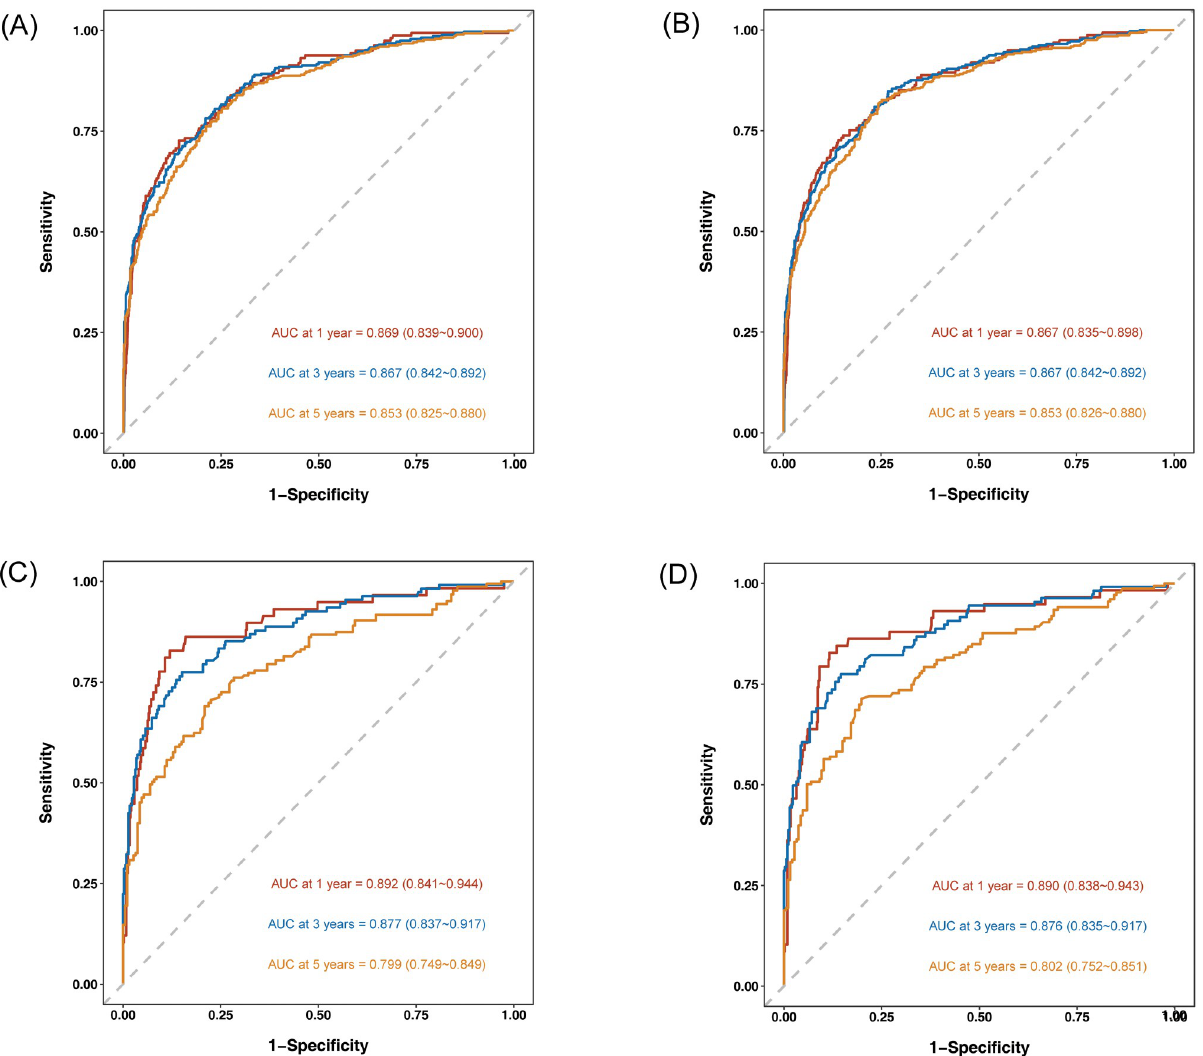
Fig 5. Time-dependent ROC curves for the 1-, 3-, and 5-year OS probability patients with NF-pNET in training cohort (A:NomogramA; B: NomogramB). Time-dependent ROC curves for the 1-, 3-, and 5-year OS probability patients with NF-pNET in validation cohort (C:NomogramA; D: NomogramB).